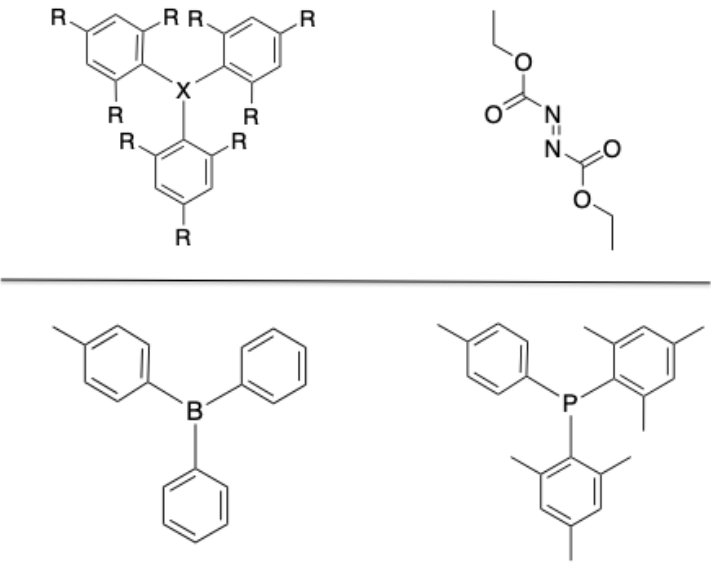
Figure 1. Top: Molecular models of the Lewis acids (X = B) and bases (X = P) substituted by electron- donating (R = CH 3 , NH 2 , OH, OCH 3 and OCOCH 3 ) and electron-withdrawing (R = F, CF 3 , CN, NO 2 and SO 3 H) functional groups (left), and the linker molecule, DEAD (right). Bottom: Reference Lewis acid and base from the experimental work